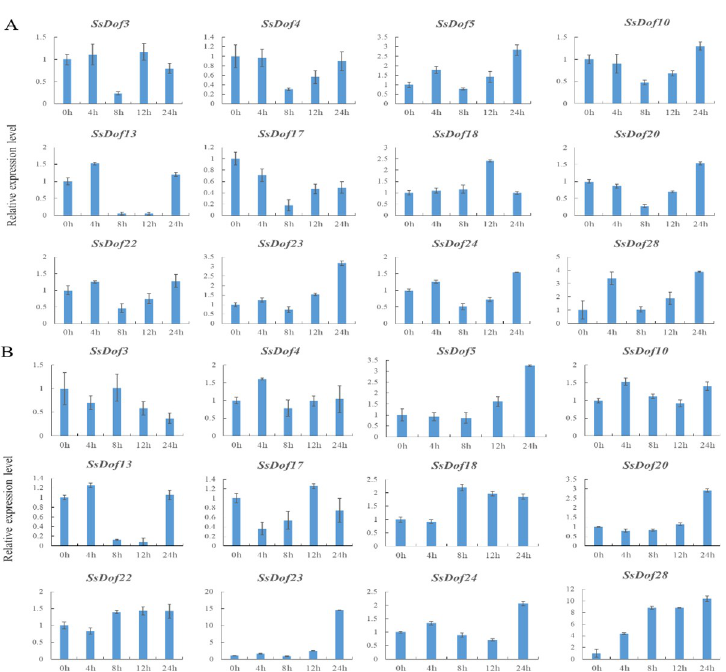
Fig 10. Expression levels of SsDof genes under salt and drought treatments by qRT-PCR. The tissue samples were obtained from leaf in seeding stage (45 days old). The standard deviation was indicated with the vertical bars. (A). The sugarcane seedlings were performed with 100 mM NaCl for 4, 8, 12 and 24 h respectively. (B). The sugarcane seedlings were performed with 15% PEG6000 for 4, 8, 12 and 24 h